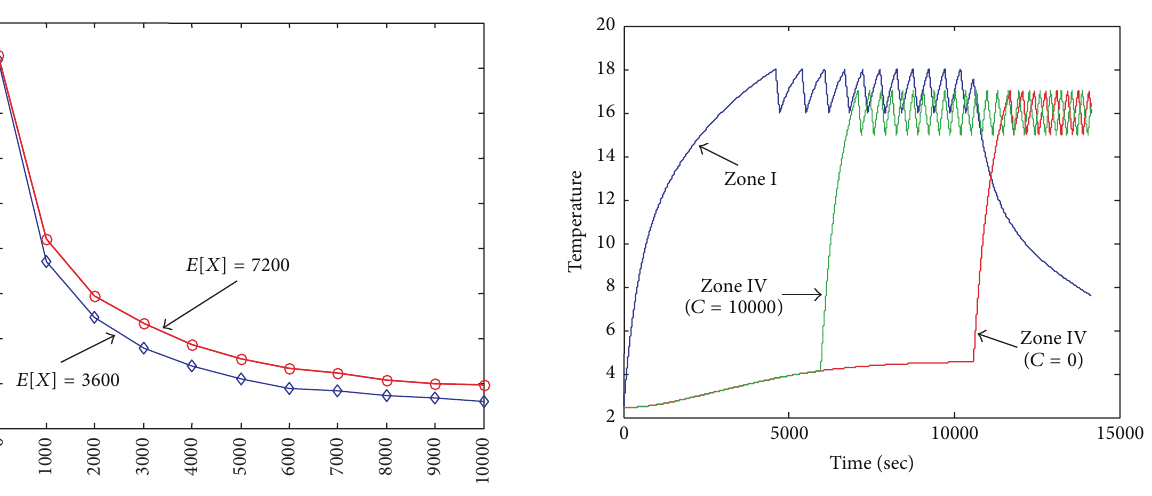
Figure 10: Temperature versus time for 𝐶 = 10000 and 𝐶 = 0 .